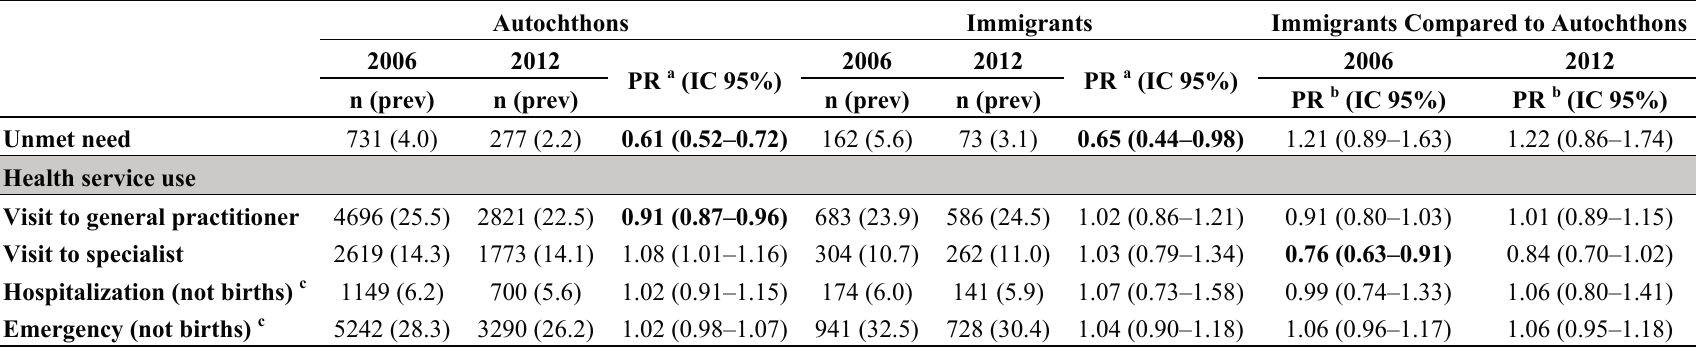
Table 2. Changes in unmet health need and in the use of different levels of care for autochthons and immigrants by year and group. Autochthons Immigrants Immigrants Compared to